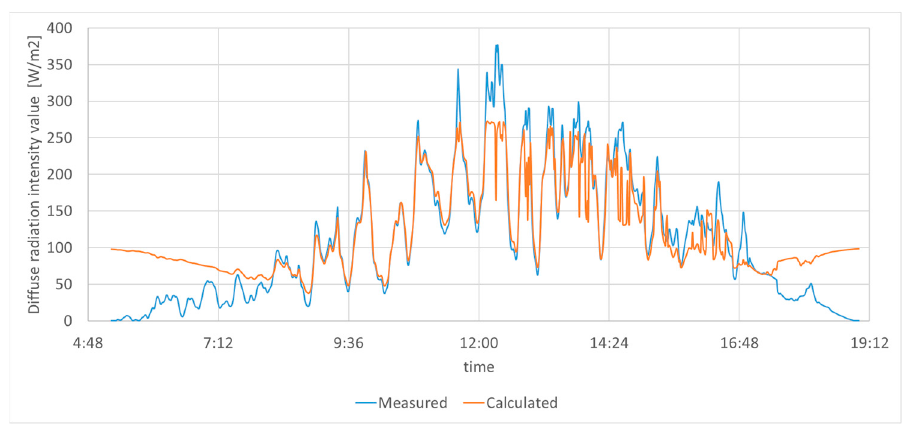
Figure 17. Comparison of measured and calculated diffuse irradiance by using a heuristic function based on the cosine